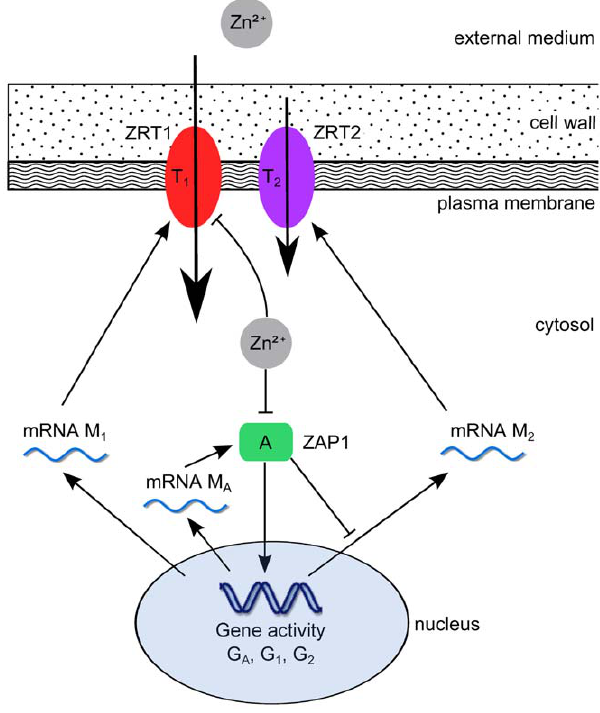
Figure 1. Yeast: scheme of zinc influx regulation model. ZAP1 is inactivated by zinc and activates transcription of the transporters ZRT1 and ZRT2.